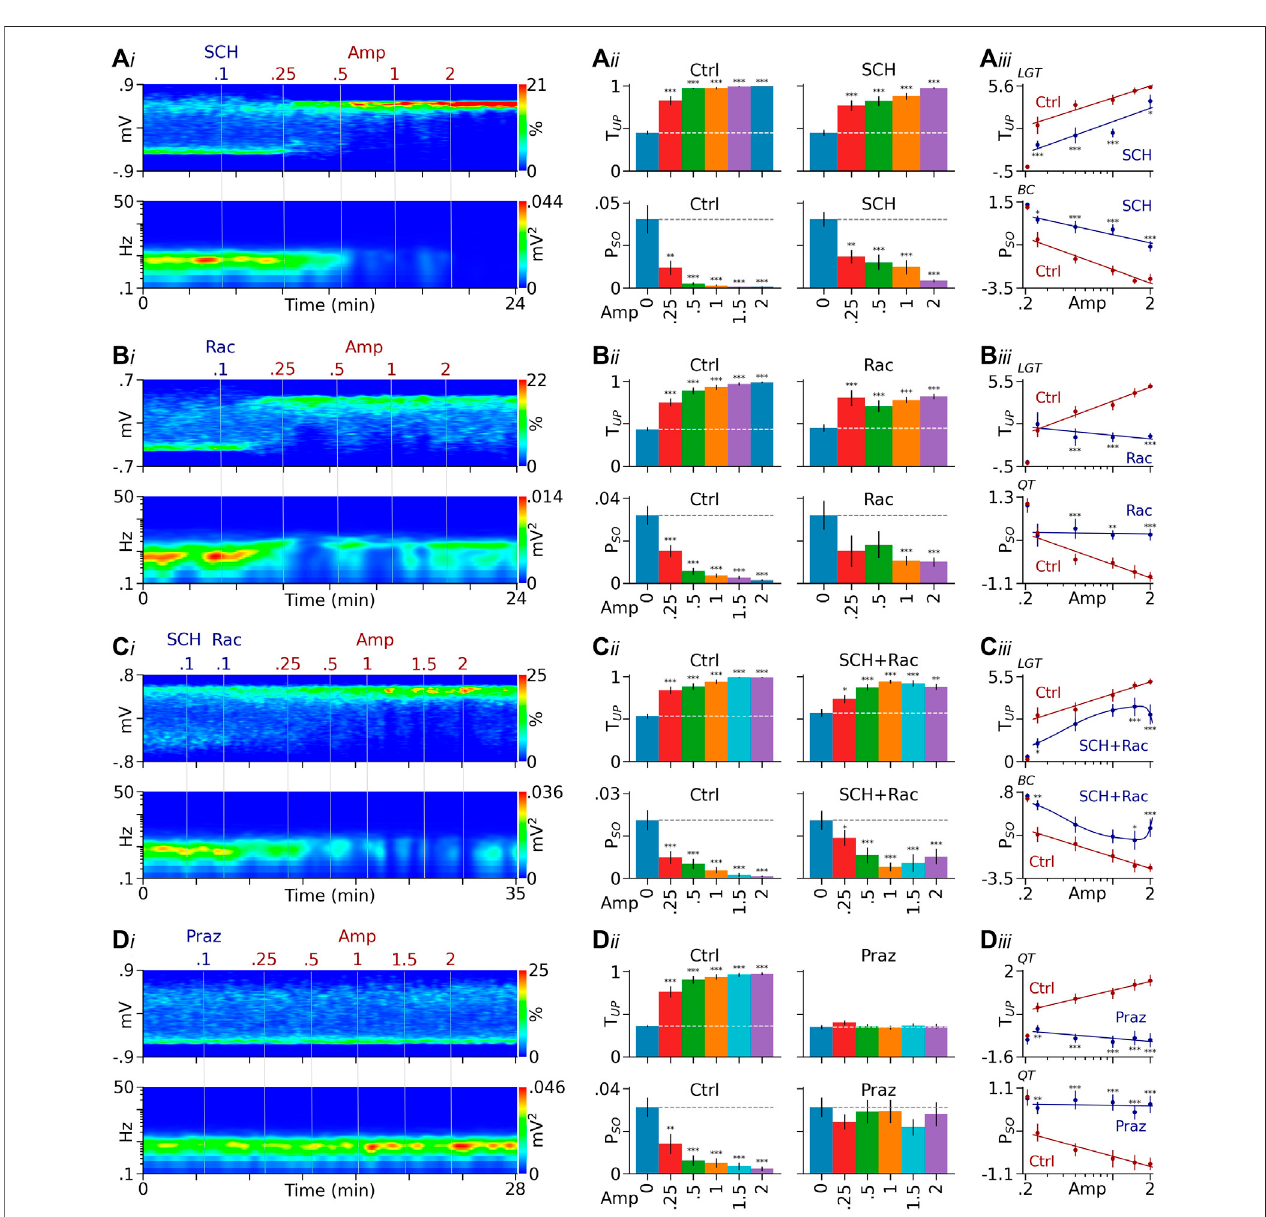
FIGURE 2 | DA receptor antagonists attenuate D -amphetamine ’ s effects. (Ai) Heatmaps from a typical rat showing that after a pretreatment with the D1-like receptor antagonist SCH23390 (SCH), D -amphetamine (Amp) remained effective in promoting PFC Up state (top) and suppressing Up/Down oscillations (bottom). (Aii) Summarybargraphsshowingthat D -amphetamine ’ seffectsonT UP andP SO weresigni fi cantinbothcontrol(Ctrl)andSCH23390-pretreatedrats(SCH). (Aiii) Compared to controls, however, SCH23390 pretreatment signi fi cantly reduced the effect of D -amphetamine (see Results for detailed statistics). (Bi) Results from a separate ratshowingthattheeffectof D -amphetaminealsopersistedafterblockadeofD2-likereceptorsbyraclopride(Rac). (Bii,Biii) Comparedtocontrols,however,raclopride- pretreatment signi fi cantlyreduced theeffect induced byhigh doses of D -amphetamine. (Ci) Heatmaps from another rat showing that D -amphetamine ’ seffect continued after a pretreatment with both SCH23390 and raclopride. (Cii, Ciii) Compared to controls, the pretreatment reduced the effect induced by low and high, but not intermediate, doses of D -amphetamine. (Di) Data from another rat showing that the α 1 receptor antagonist prazosin (Praz) completely prevented D -amphetamine from promotingtheUpstateandsuppressingtheslowoscillation. (Dii,Diii) Comparedtocontrols,prazosinblockedtheeffectinducedbyalldosesof D -amphetaminetested. The y -axis values in dose-response curves are logit (LGT), Box-Cox (BC), or quartile-transformed (QT). * p < 0.05, ** p < 0.01, *** p < 0.001 vs baseline (blue bars) or the same dose of D -amphetamine in control rats (red